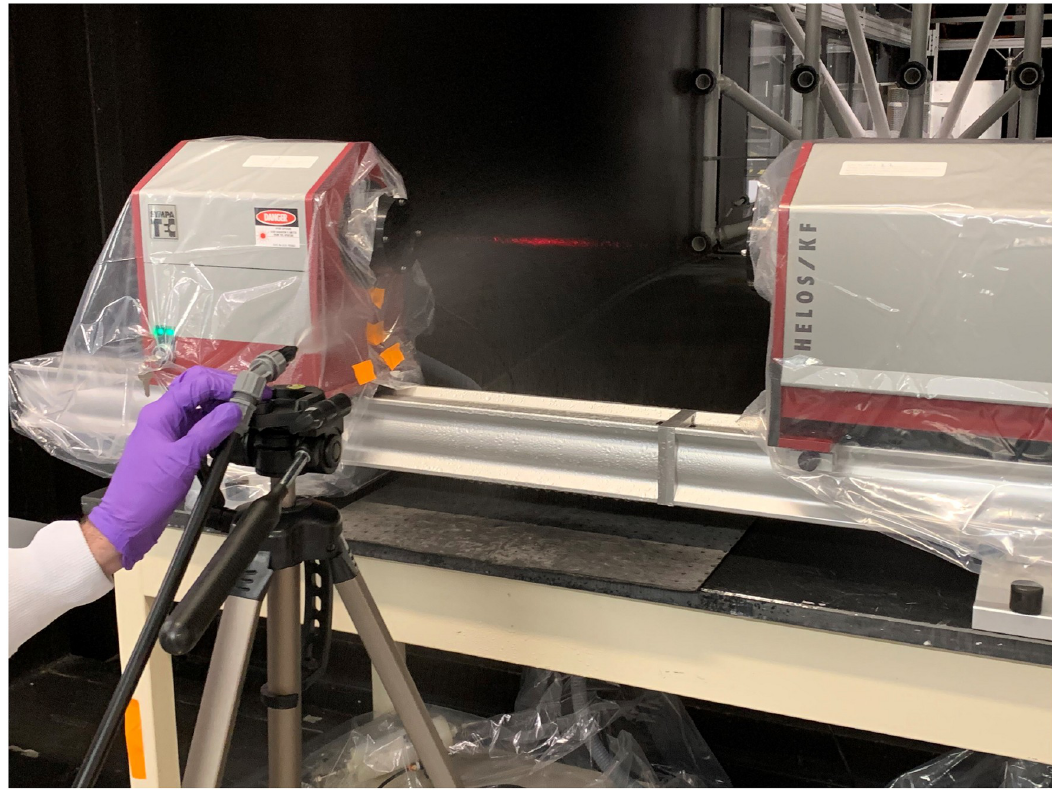
Fig 1. Photograph of a spray cone being directed into the optical path of the laser diffraction instrument. Note resulting illumination of the red laser beam.